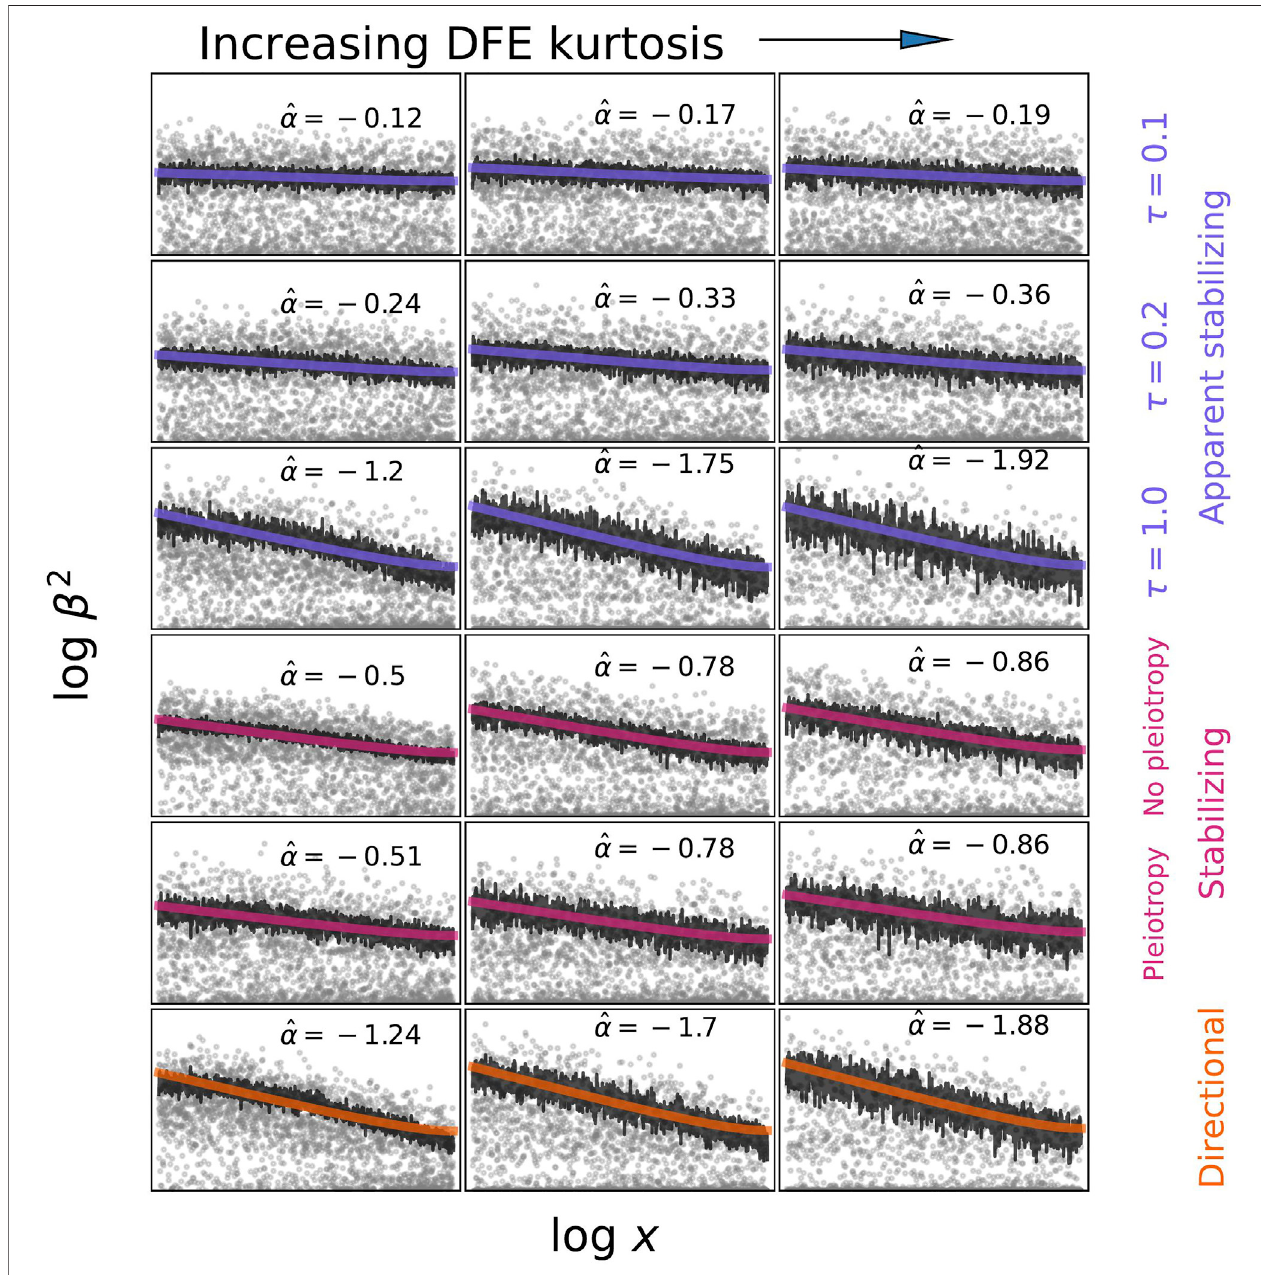
FIGURE 2 | Examples of what alpha models may infer under different models of selection and different distributions of fi tness effects (DFE). Effect sizes were simulated by sampling from p ( s | x ) and then from p ( β | s ) under the different models described in the text. Derived allele frequencies are uniform between 0.01 and 0.5. Estimates of α were obtained by fi tting log β 2 (cid:1) α log x (1 − x ) + c to the average β 2 | x values calculated from simulations. The DFE was varied by decreasing the shape parameter from 1 to 0.25 to 0.125 while keeping the mean constant. It is important to recognize that ^ α values reported here would not necessarily correspond to those obtained by real statistical genetics methods (Zeng et al., 2018; Schoech et al., 2019; Speed et al., 2020; Zeng et al., 2021). Those methods employ particular likelihoods and are applied to real genetic data where frequencies are not uniform and effect sizes are estimated with error. The frequencies of analyzed variants may be particularly important since the slope of the ( β 2 , x ) relationship (local α ) varies with frequency (Schoech et al., 2019). Estimated α values increase with increasing DFE kurtosis, re fl ecting the proportion of variants that are strongly selected. For high kurtosis, estimates approach the theoretical expectation of α (cid:1) − 2 τ for the Eyre-Walker (2010) model as derived by Schoech et al. (2019). As expected, in a model of stabilizing selection (Simons et al., 2018), the degree of pleiotropy does not affect the α estimate. Directional selection is associated with higher α estimates than stabilizing selection.